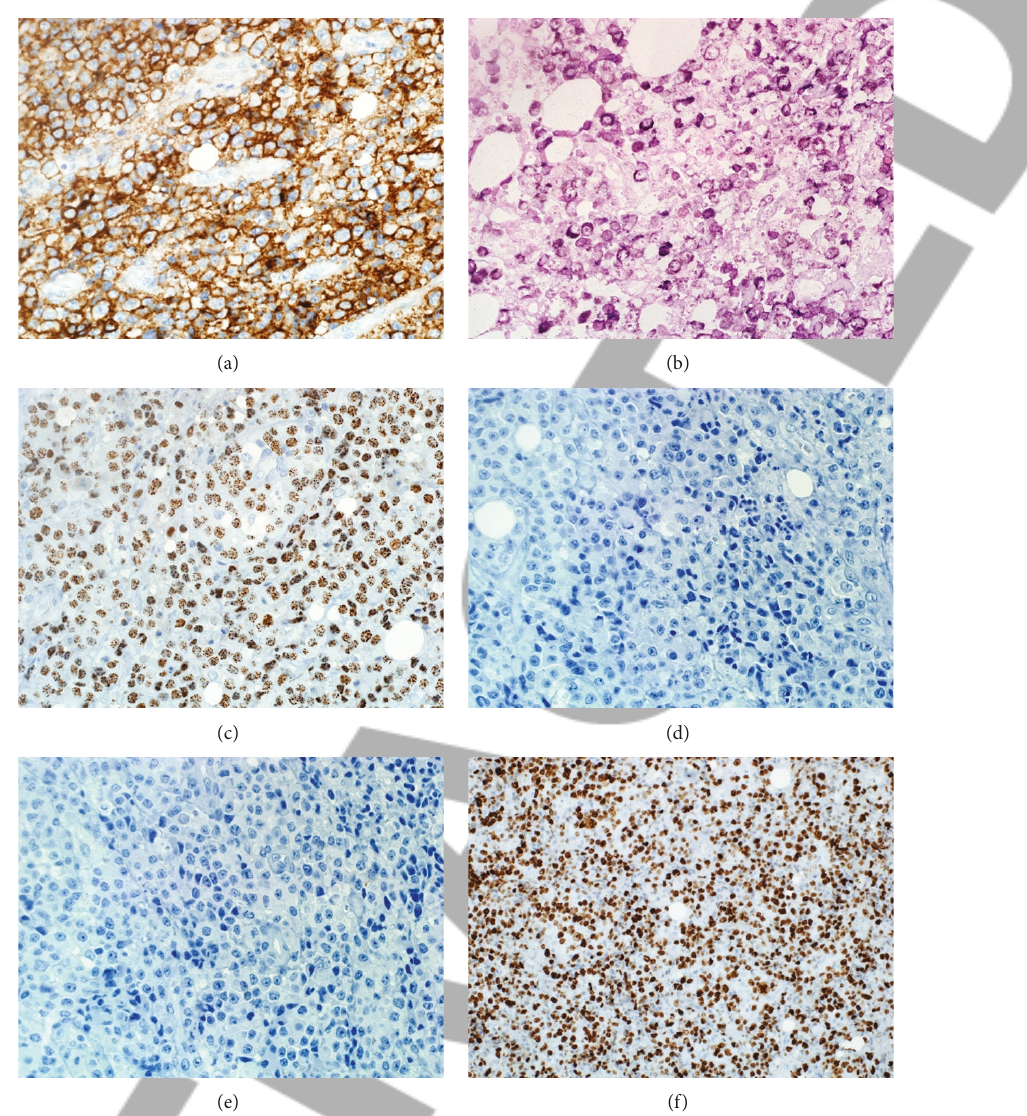
Figure 2: Selected immunophenotype of PBL: the PBL cells demonstrate immunoreactivity to CD138 (a), lambda light chain, ISH (b), and HHV8 (c) and negativity for CD20 (d) and CD56 (e). Proliferation index is high (f).